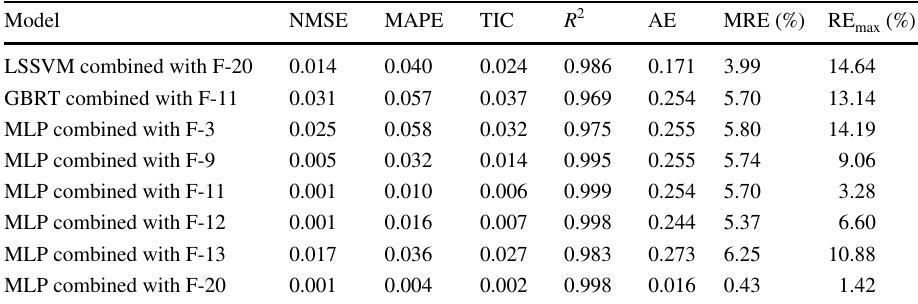
Table 4 Optimization model evaluation indicators